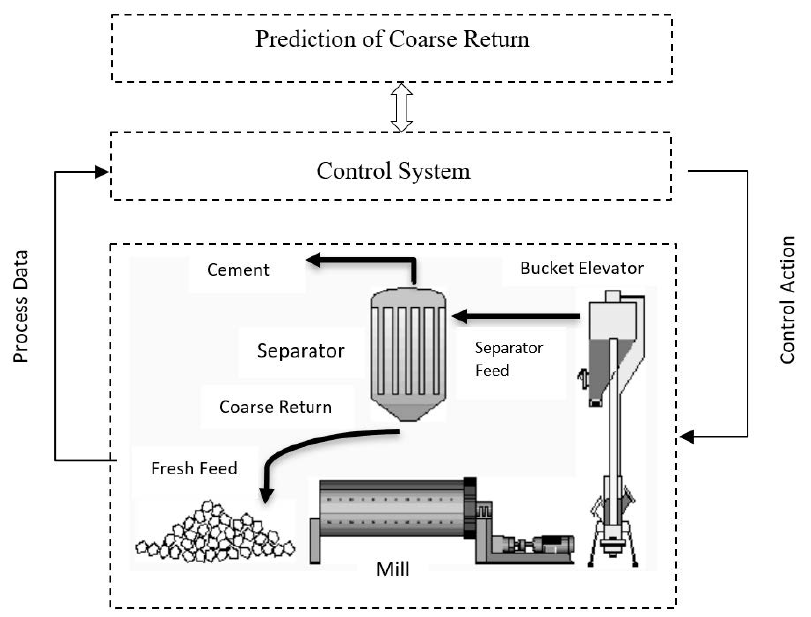
Figure 1. A schematic of a closed-loop cement grinding control system. Adapted from [6].